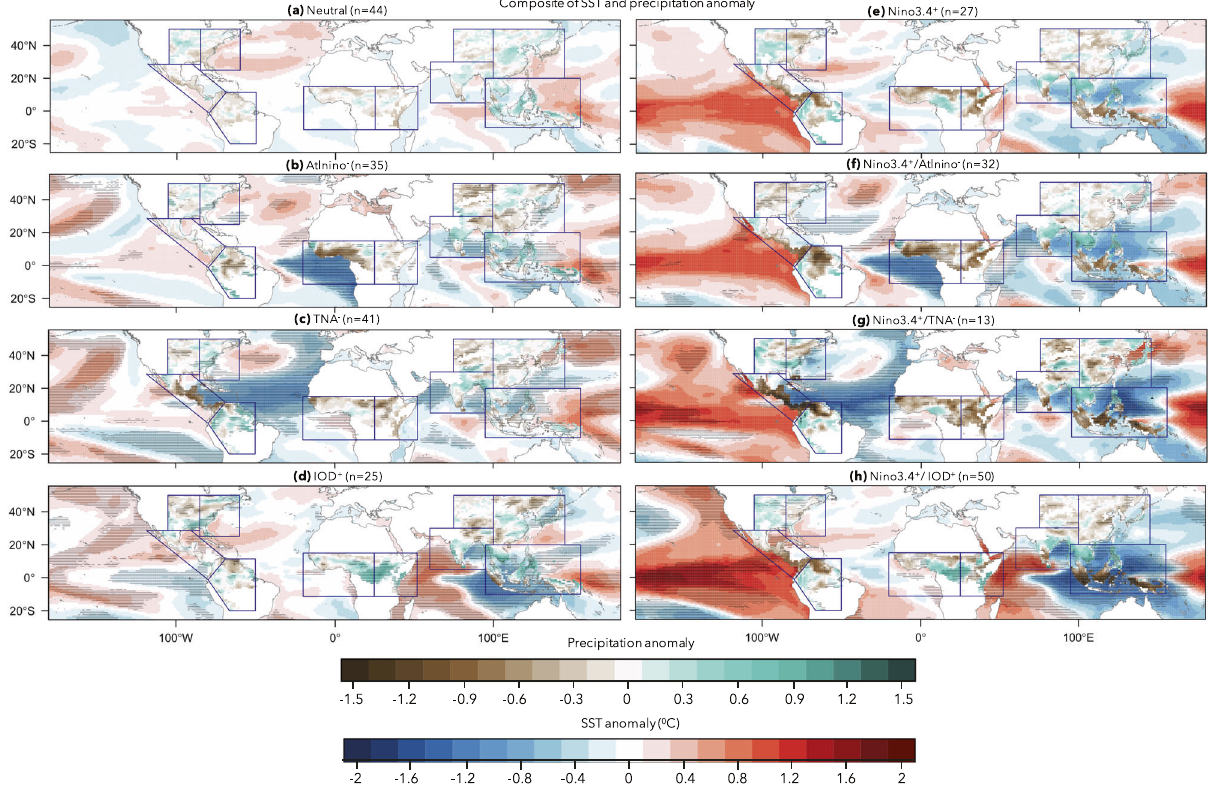
Fig. 4 Simulated in fl uence of individual variability modes and co-occurring conditions. Composites of precipitation and SST anomalies during a neutral conditions, b AtlNiño − conditions only, c TNA − conditions only, d IOD + conditions only, e Niño3.4 + conditions only, and co- occurring f Niño3.4 + /AtlNiño − , g Niño3.4 + /TNA − , and h Niño3.4 + /IOD + conditions. Numbers in the headings indicate the number of summer seasons with individual and co-occurring phases of the modes used in each composite. Co-occurring conditions indicated by Niño3.4 + /IOD + , Niño3.4 + /AtlNiño − , and Niño3.4 + /TNA − denote co-occurrences of speci fi c modes while other modes are in their neutral phases. The hatched SST and precipitation composites on the left indicate signi fi cant differences in the composite mean relative to neutral conditions and on the right indicate signi fi cant differences in the composite mean relative to Niño3.4 + conditions, at 5% signi fi cance